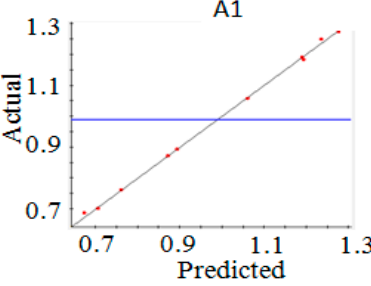
Figure 7. Comparison between calculated results and approximate model with no fault.